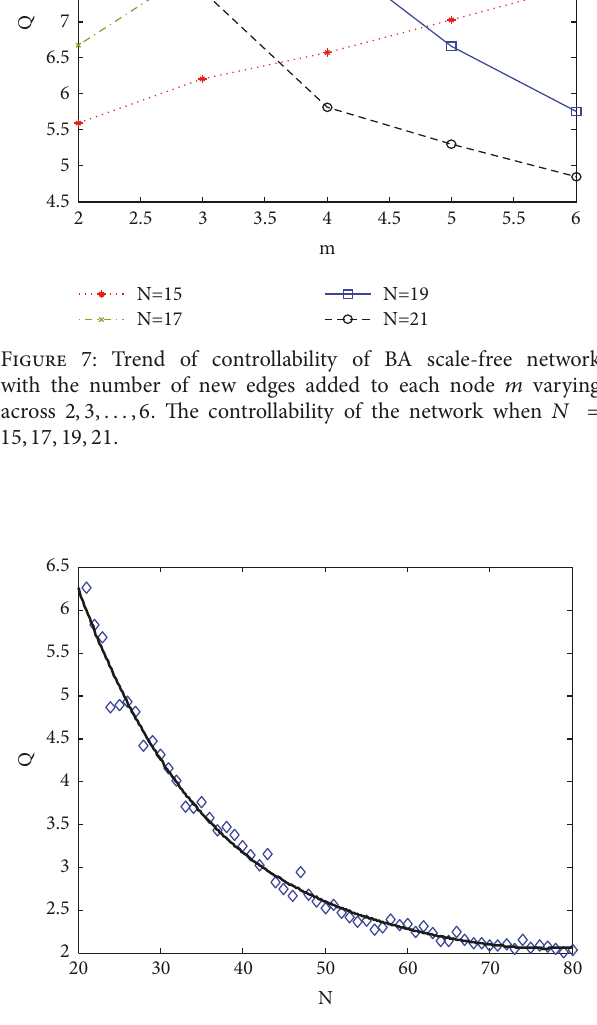
Figure 8: Trend of controllability of BA scale-free network with the number of nodes 𝑁 varying across 20, 21,.. ., 80